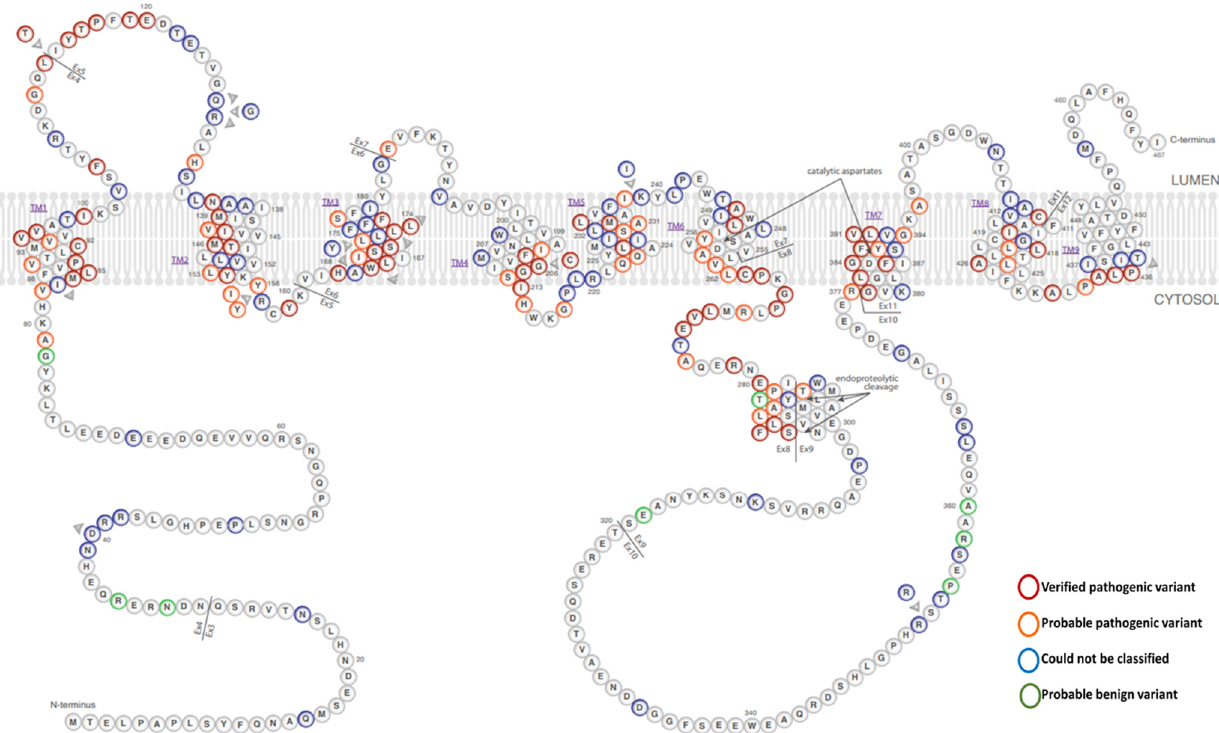
Figure 2 . Mutation sites in PSEN1 protein . Figure 2. Mutation sites in PSEN1